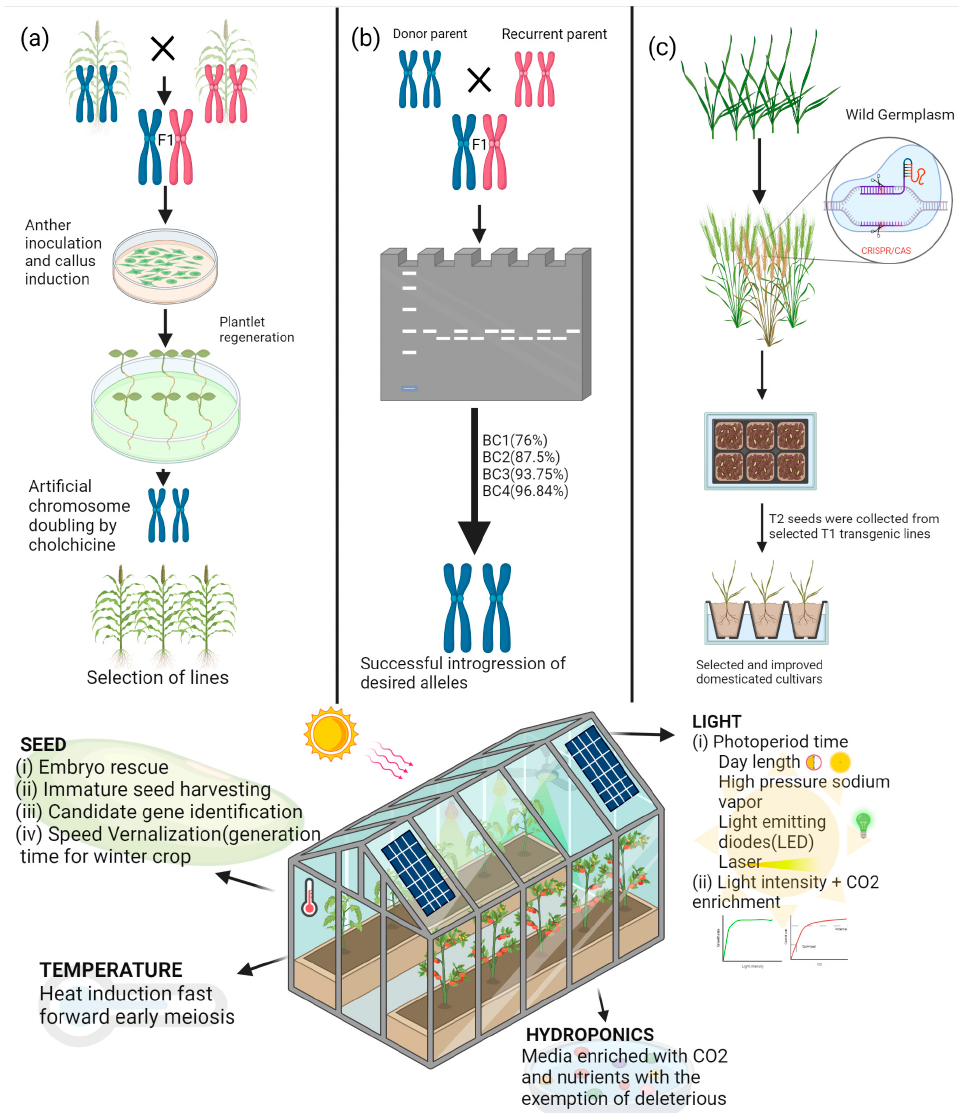
Figure 2. Integration of SB with other breeding techniques accelerates the rate of progress. The ho ‐ mozygous lines for research and breeding purposes can be obtained expeditiously through hastening procedures aimed at ( a ) DH production, ( b ) marker ‐ assisted selection, and ( c ) gene editing. The image was created using BioRender (https://biorender.com/ accessed on 20 January 2022 ).